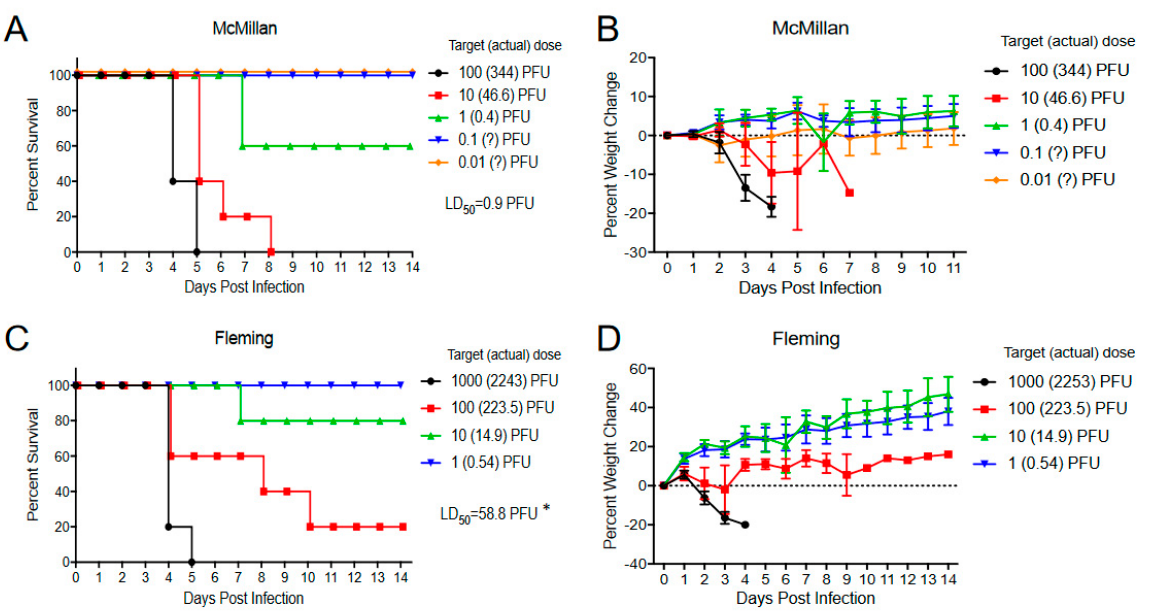
Figure 11. Aerosol LD 50 mortality curves ( A , C ) and weight loss data ( B , D ) for 4–week–old CD–1 mice infected with each indicated virus. Values with question marks are estimates of aerosol dose based on virus dilution. Aerosol LD 50 infections included 5 or 10 mice per group and were replicated with at least four dilutions per experiment. Error bars are standard deviations. * = LD 50 McMillian vs. Fleming p < 0.001.